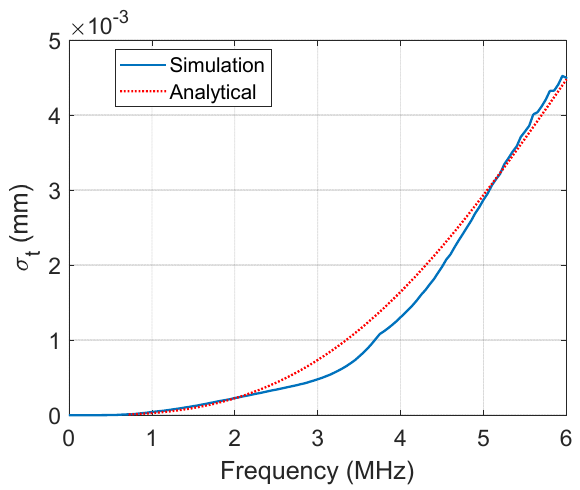
Figure 6. Total scattering cross-section ( 𝜎 (cid:3047) ) for a circular particle in 2-D.